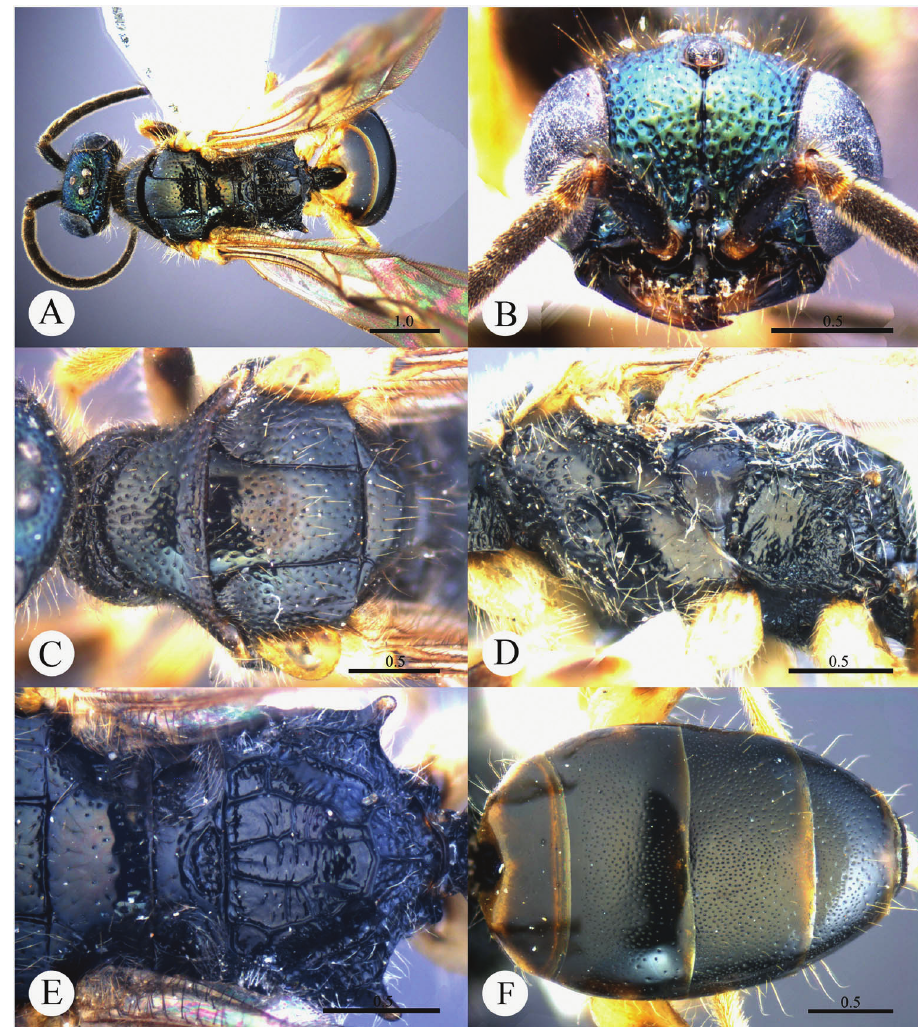
Plate 2. Cleptes eburnecoxis sp. n., holotype, male. A Habitus dorsal B Head anterior C Pronotum and mesoscutum dorsal D Mesopleuron and metapleuron lateral e Mesoscutellum, metanotum and propo- deum dorsal F Metasoma dorsal. Scale bars in